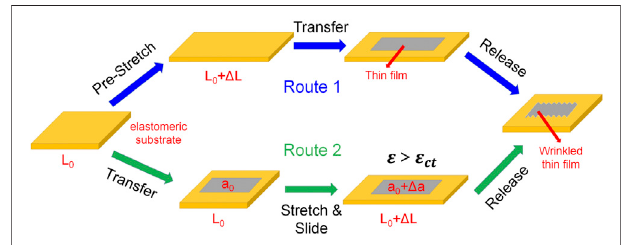
FIGURE 1 | Schematics of the two routes for wrinkle generation within a bilayer